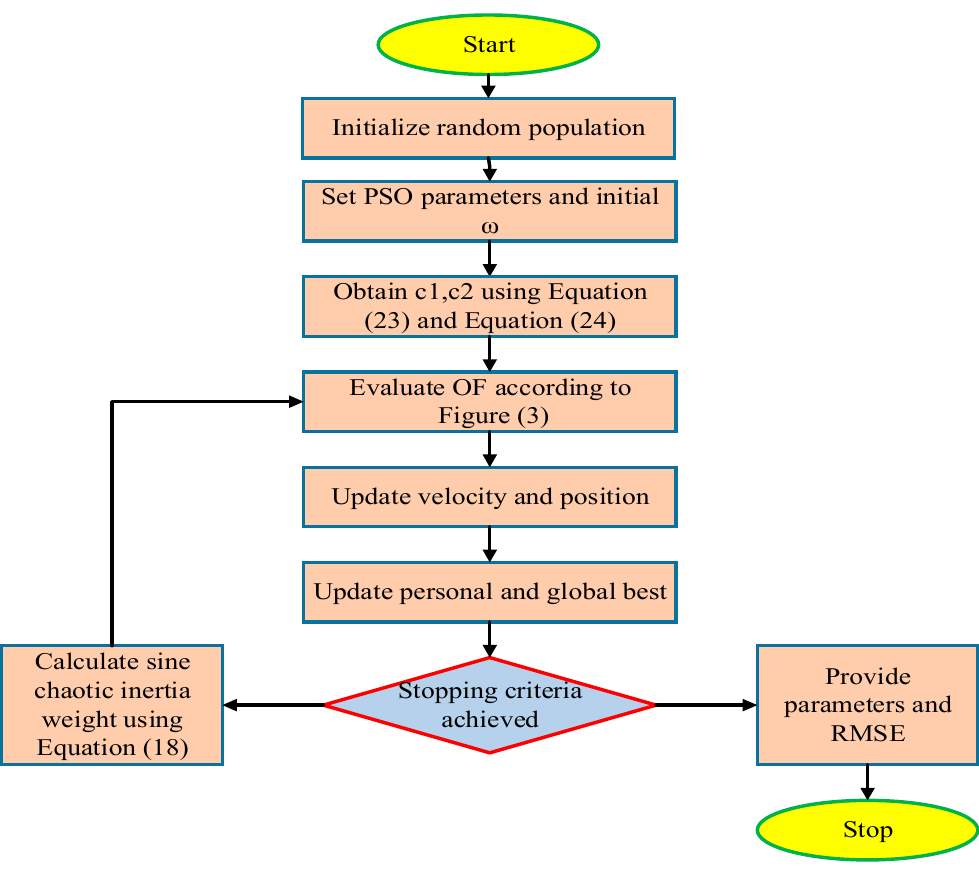
Figure 4. Flowchart of the proposed technique for the parameter estimation of PV models.